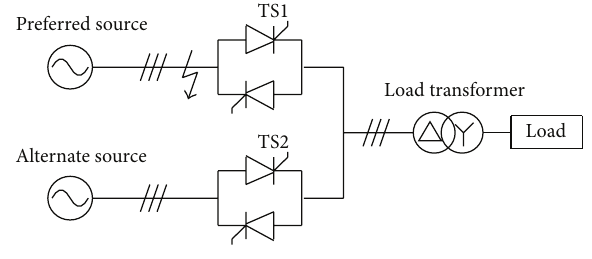
Figure 1: STS and the load transformer.